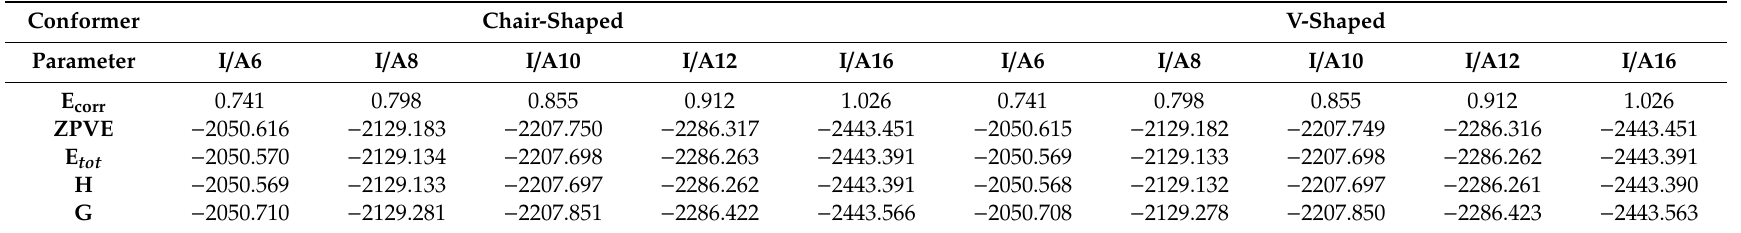
Table 2. Thermal parameters (Hartree / Particle) of both conformers of the H-bonded complexes I / An. Conformer Chair-Shaped